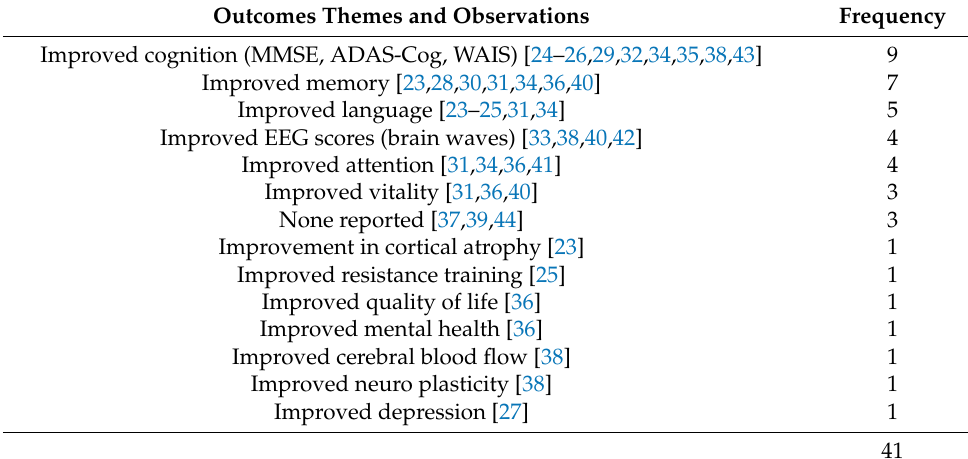
Table 4. Medical outcomes commensurate with the adoption of mHealth and VR. Outcomes Themes and Observations